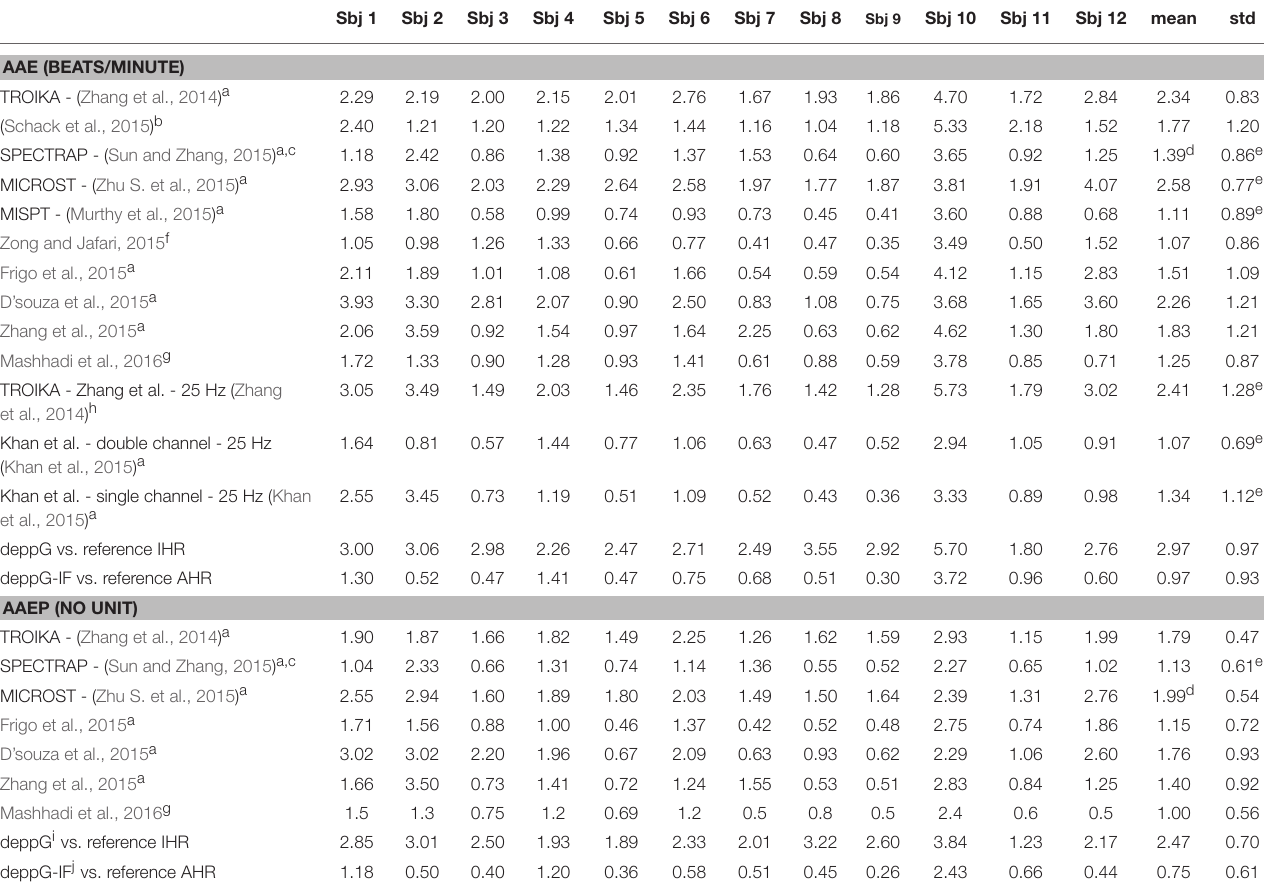
TABLE 2 | The average absolute error (AAE, the same as the mean absolute error) and average absolute error percentage (AAEP) of the heart rate estimation for the ICASSP 2015 signal processing cup